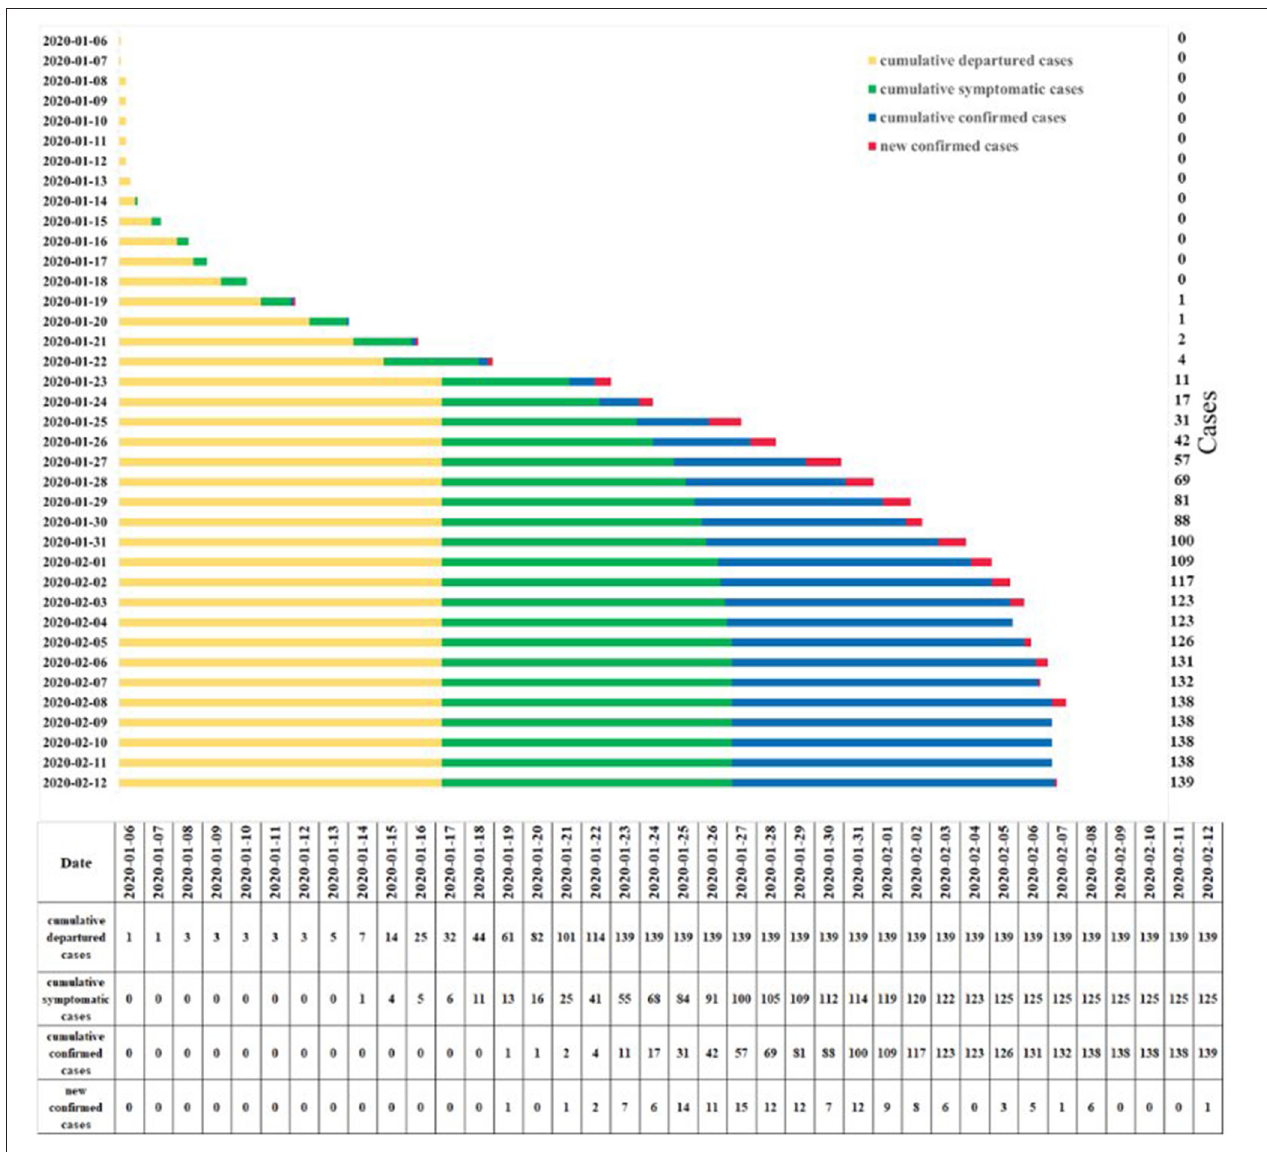
FIGURE 2 | Time distribution of all patients after they left Wuhan